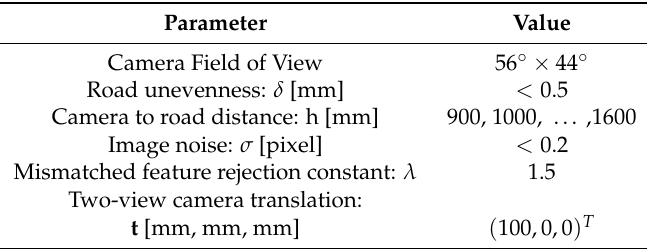
Table 2. Parameters for experiments using real